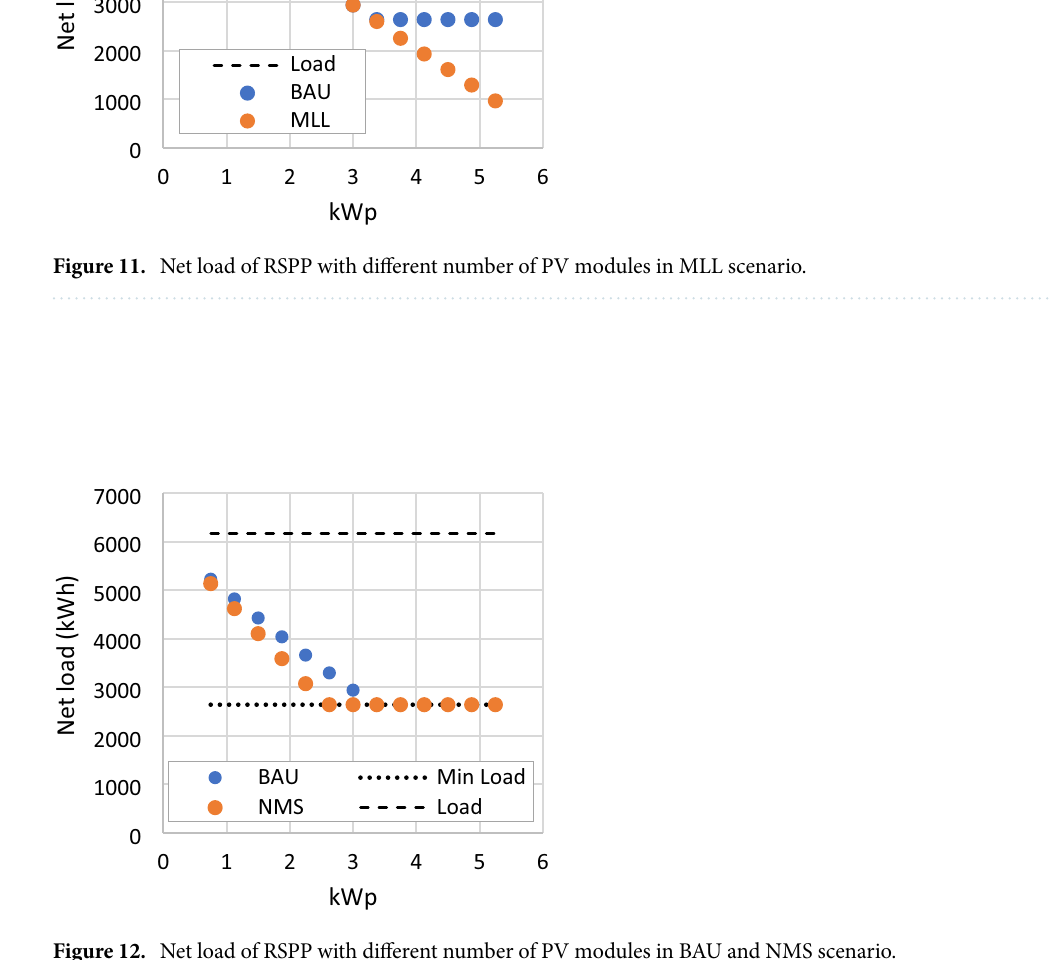
Figure 12. Net load of RSPP with different number of PV modules in BAU and NMS